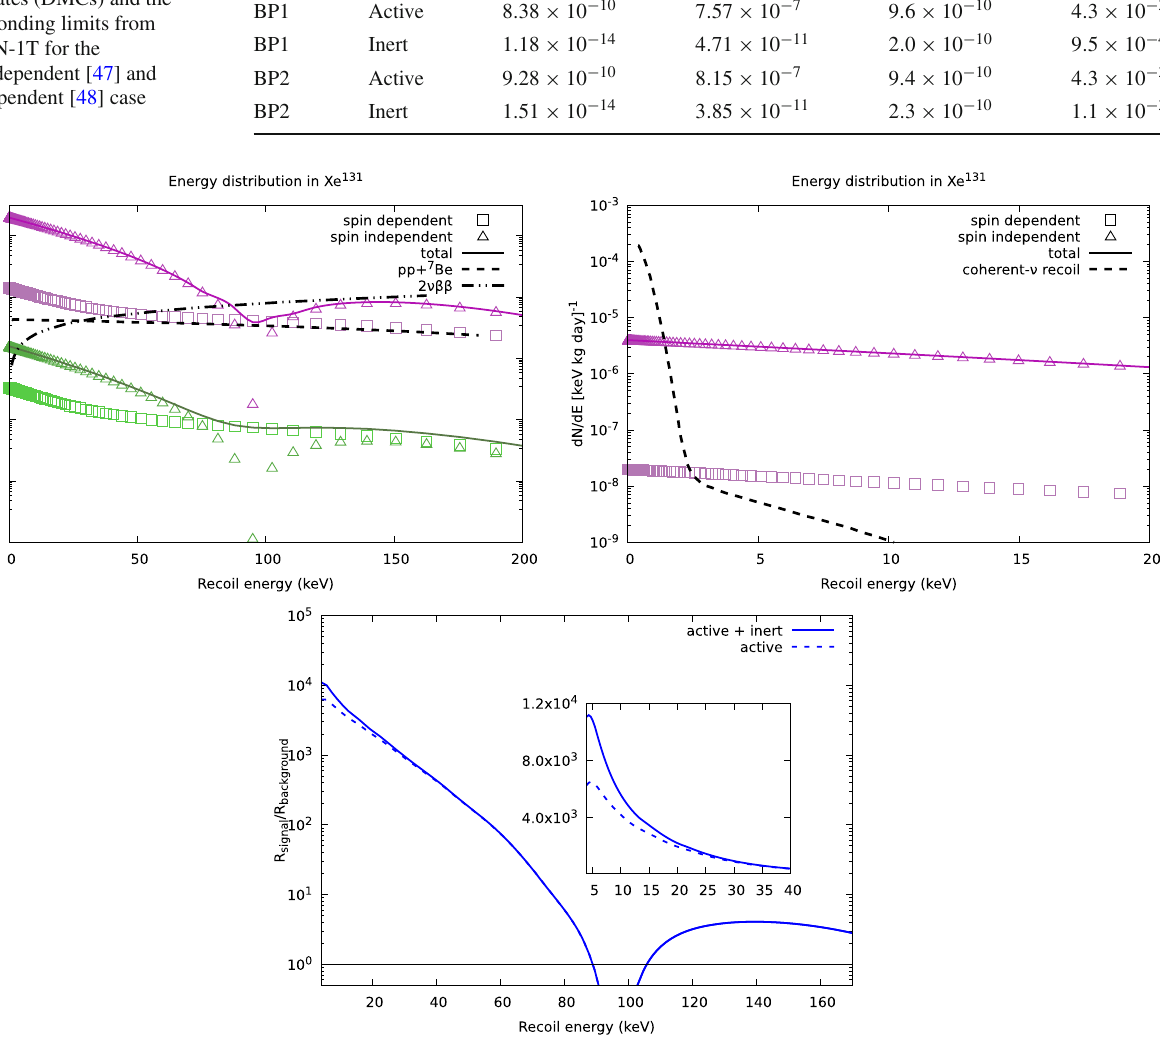
and the 7 Be-neutrinos (from the electron capture reaction 7 Be + e − → 7 Li + ν e ) [53]. Other elastic neutrino-electron